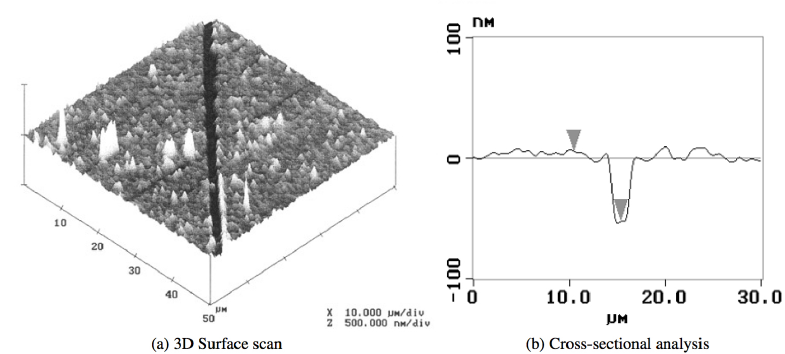
Figure 10. An AFM cantilever tip was used to scratch a furrow in a 14-bilayer polymer-polyelectrolyte film on a silicon substrate. Cross-sectional analysis revealed the depth of the furrow, and therefore, the thickness of the film, to be approximately 54nm. (Reprinted from [62], Copyright IOP Publishing,